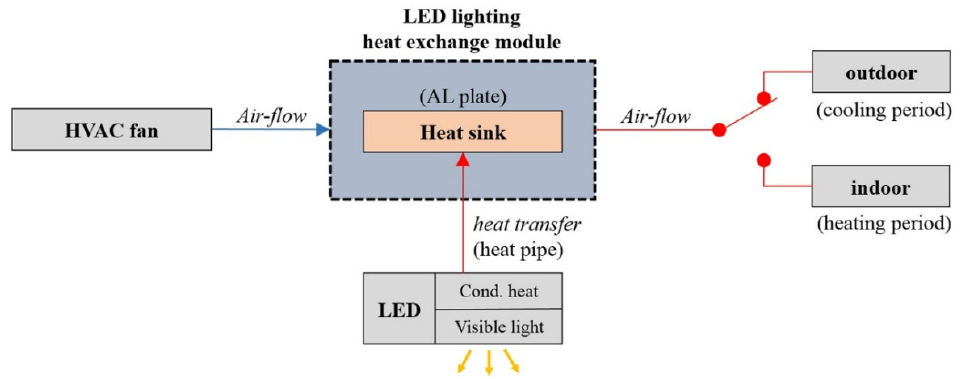
Figure 2. Schematic view of an alternative thermal management system with an LED